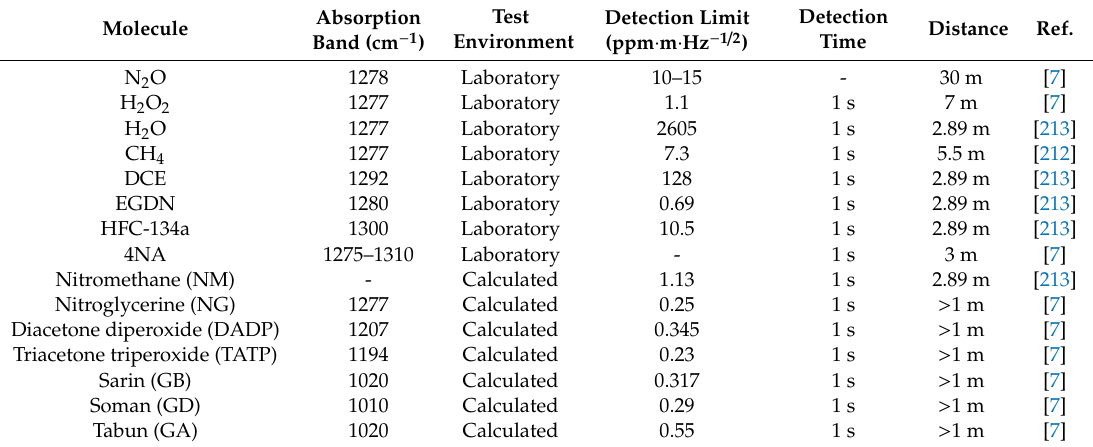
Table 7. The detection performance of active coherent laser absorption